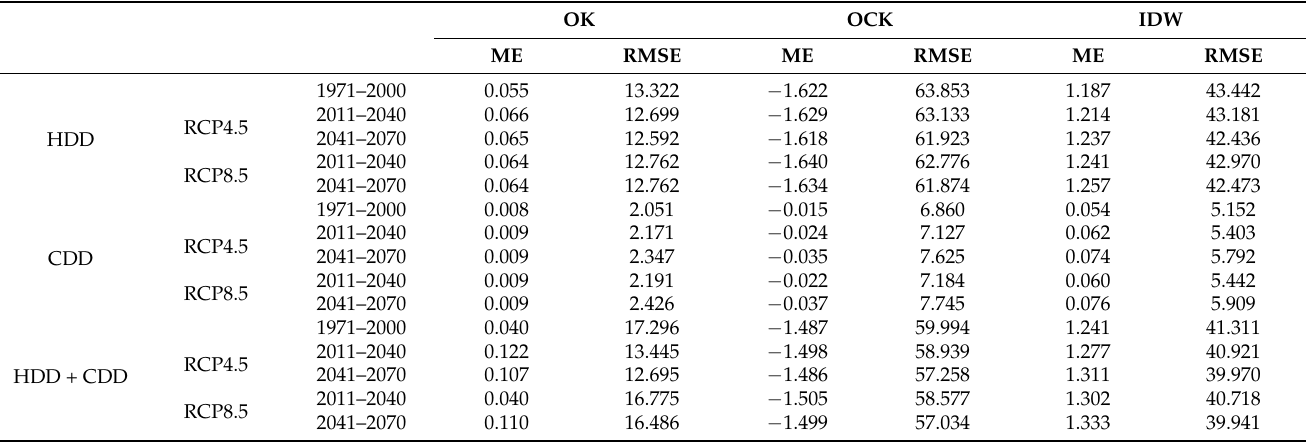
Table 4. Cross-validation statistics of the Rational quadratic model for IDW, OK and OCK methods for historical (1971–2000) and future periods (2011–2040, 2041–2070) for HDD, CDD and HDD + CDD under RCP4.5 and